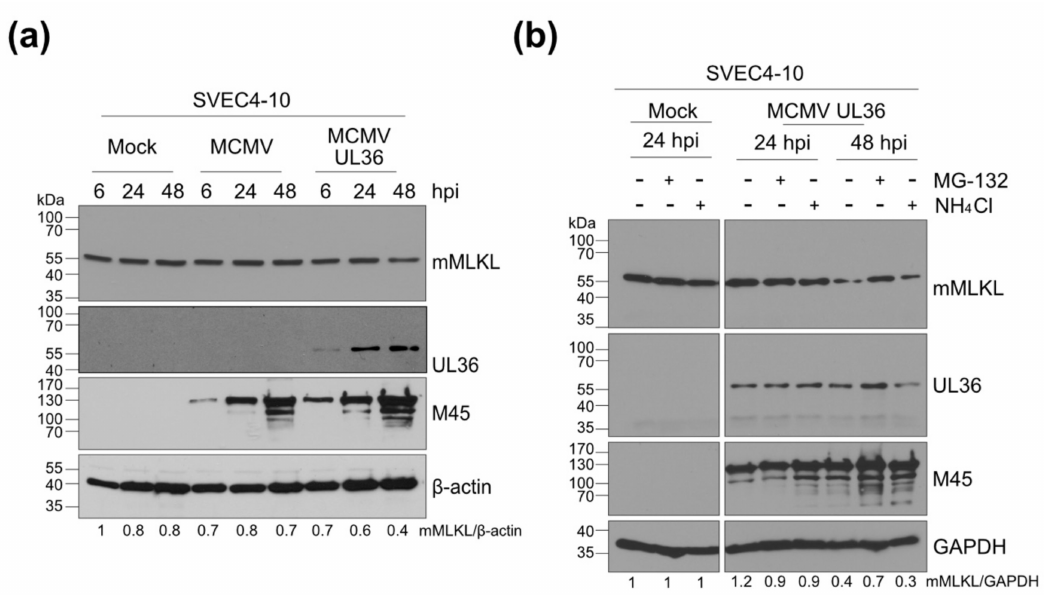
Figure 5. UL36 expression reduces mMLKL levels in MCMV-infected cells. ( a ) SVEC4-10 cells were infected with MCMV WT or MCMV-UL36. mMLKL, UL36, and M45 (infection control) levels were determined at different hours post-infection (hpi) by Western blot. ( b ) SVEC4-10 cells were infected with MCMV-UL36. Six hours before harvest, cells were treated with a lysosomal acidification inhibitor (NH 4 Cl) or a proteasome inhibitor (MG-132) or left untreated. mMLKL, UL36, and M45 levels were determined by immunoblot at 24 and 48 hpi. mMLKL levels relative to those of a housekeeping gene product were determined by densitometry and normalized to mock infected cells. + indicates treatment and – lack of treatment with the respective